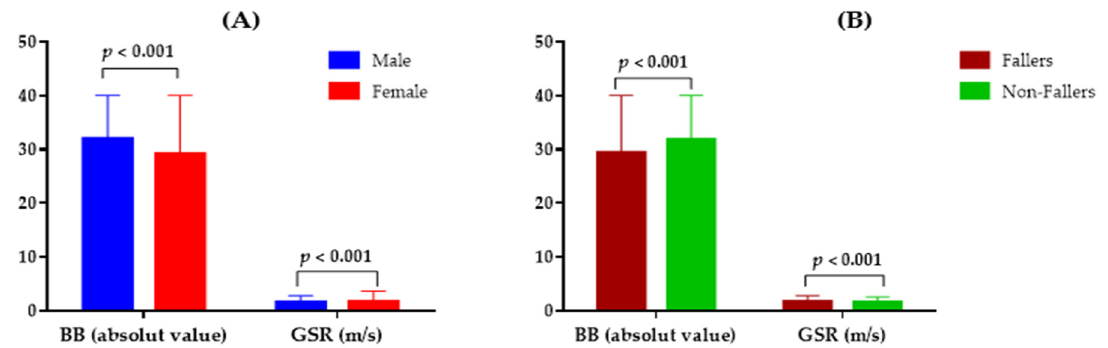
Figure 2. Comparative graph of GSR values and BB performance, according to sex and history of falls. m/s = meters per second. ( A ) Results by sex; ( B ) Results according to historical declines in the last 12 months.